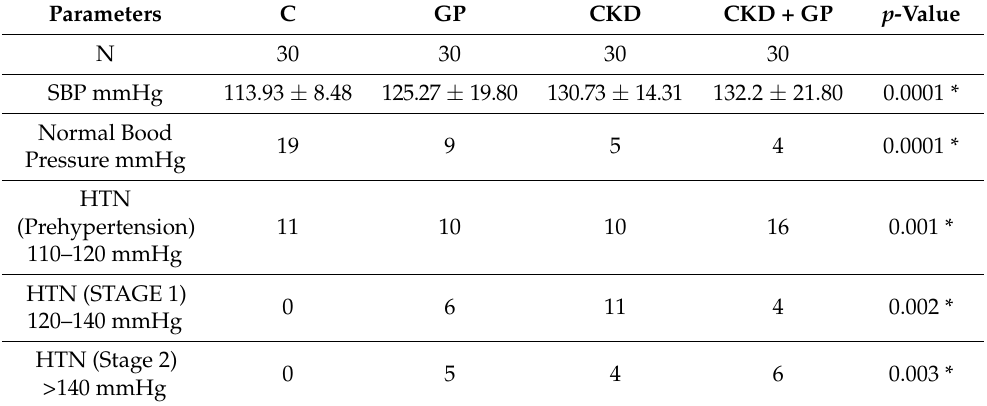
Table 5. Intergroup comparison of hypertensive variables among C, GP, CKD, and CKD + GP Groups.